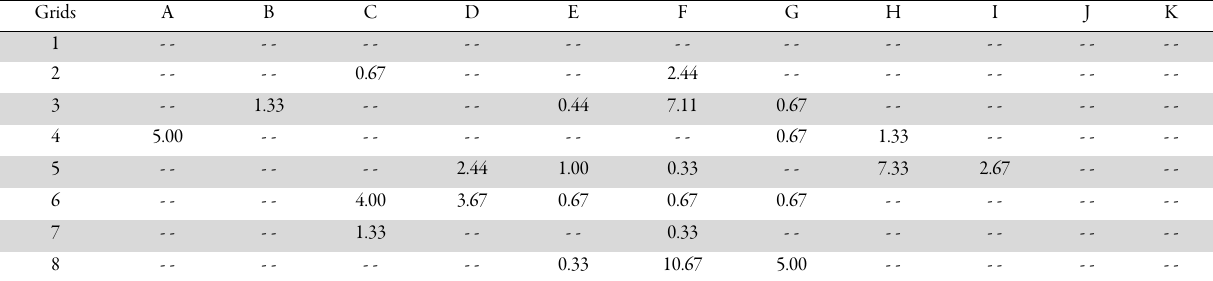
Fig. 4. A- Distribution of the sloth bear sign encounter rate in different grids of the study area; B- Sign survey trails in different forests of the study area Table 1. Encounter rate of sloth bear sign in the study area shown grid wise (sign/km in the 5 × 5 grid)